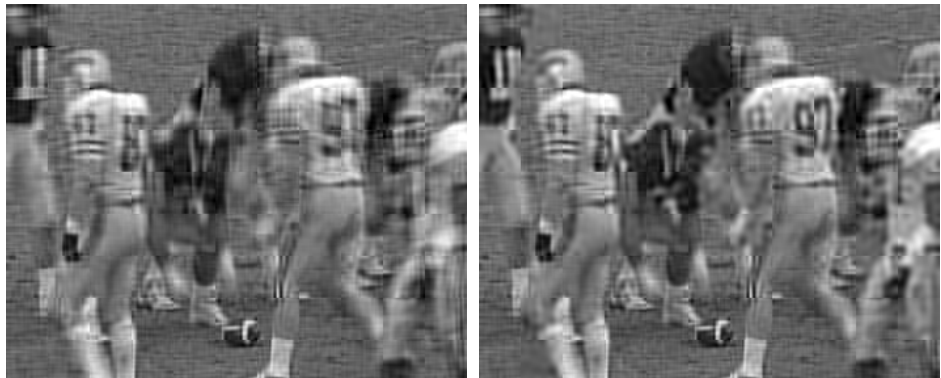
Figure 5. Visual comparison of 3D-DCT ( left ) vs. a combination of 2D and 3D-DCT ( right ) with the JSCC-Cast analog video system. The left image has SSIM = 0.61 and PSNR = 21.81dB. The right one has SSIM = 0.63 and PSNR = 22.25dB. The bandwidth ratio is set to 0.01, and the channel SNR is 30dB. Frame extracted from the transmission of the video